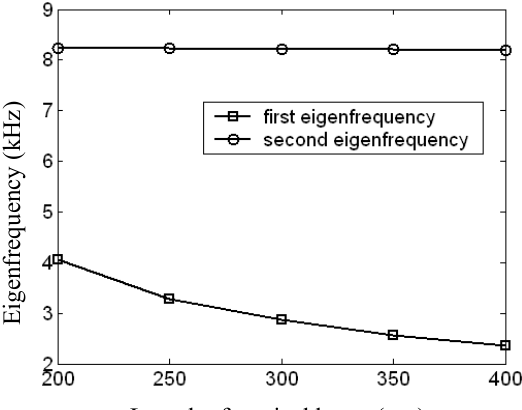
Figure 6. Length of vertical beam versus first and second